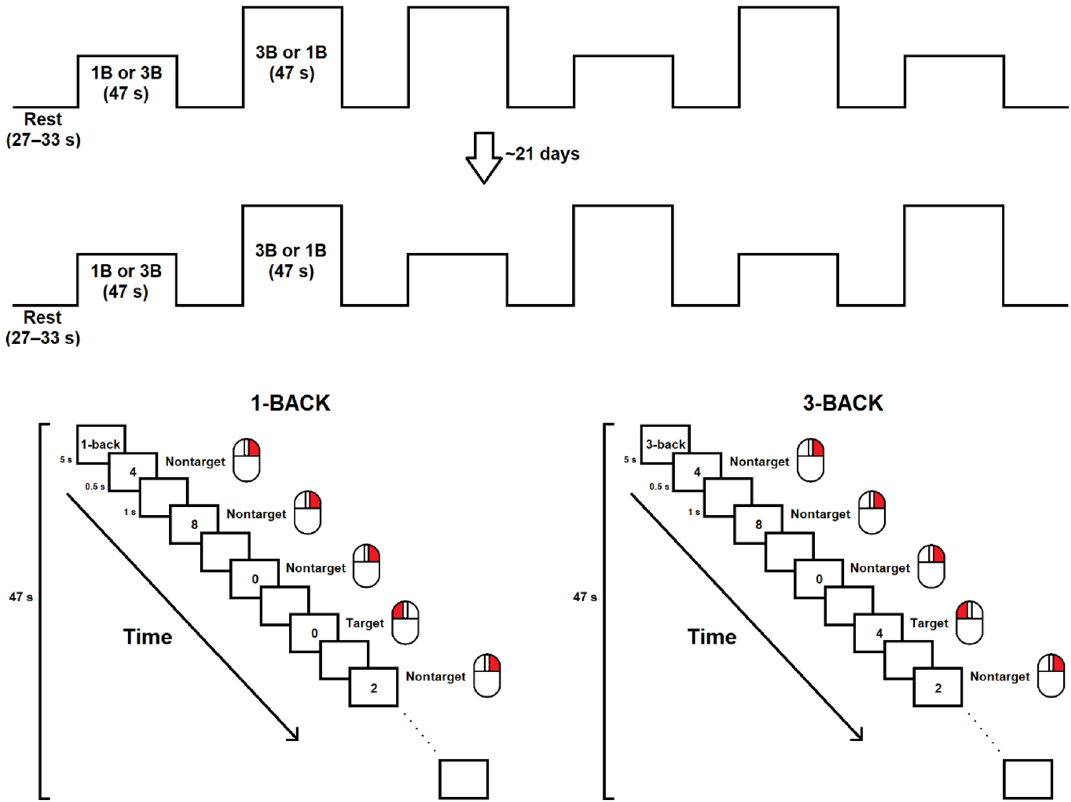
Figure 1. Study design and flow of the N-back